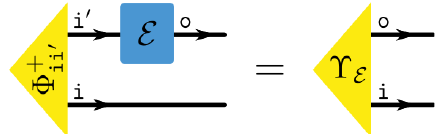
FIG. 10. Choi-Jamiołkowski isomorphism. A map E : B ( H i ) → B ( H o ) can be mapped to a matrix ϒ E ∈ B ( H o ⊗ H i ) by letting it act on one half on a maximally entangled state. Note that, for ease of notation, here, we let E act on B ( H i (cid:10) ) , such that ϒ E ∈ B ( H o ⊗ H i ) . As H i (cid:10) ∼= H i , this is merely a relabeling and not of conceptual